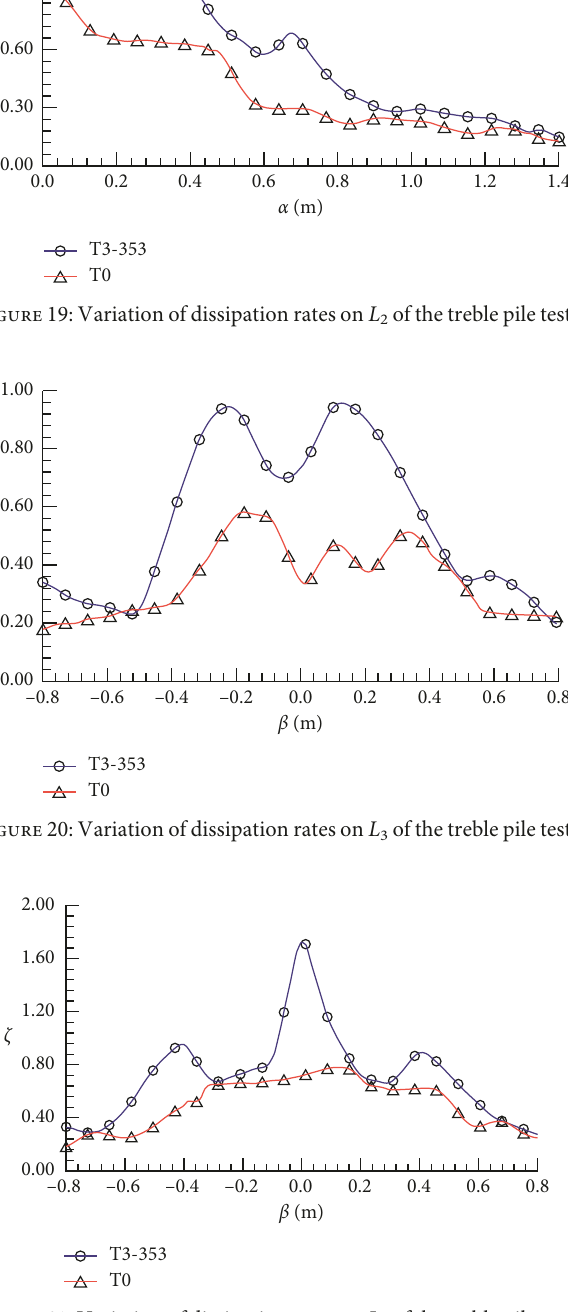
4 of the treble pile test.